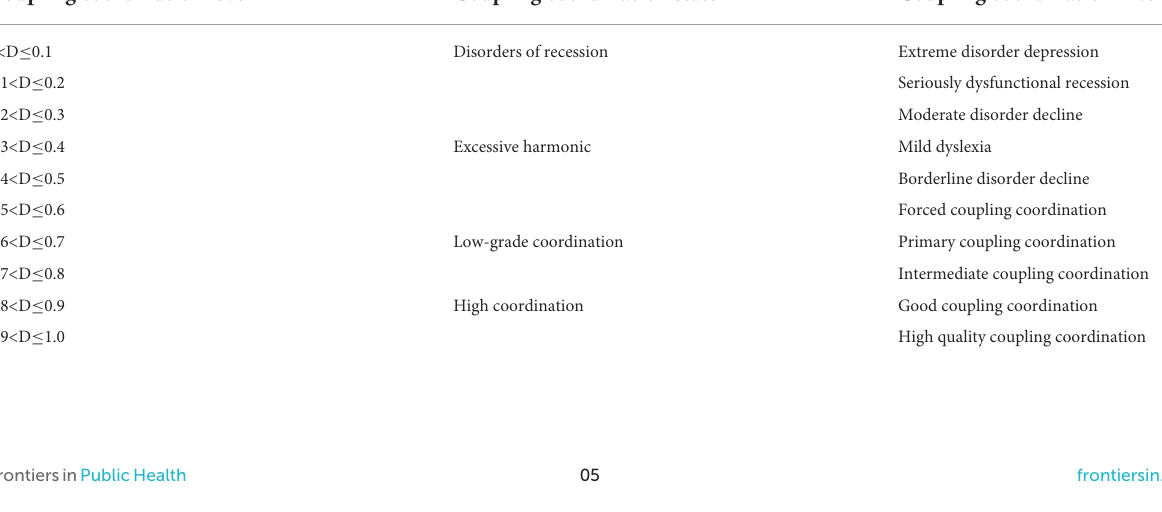
TABLE 3 Evaluation standard of coupling coordination level between low- carbon and socio-economic development. Coupling coordination level